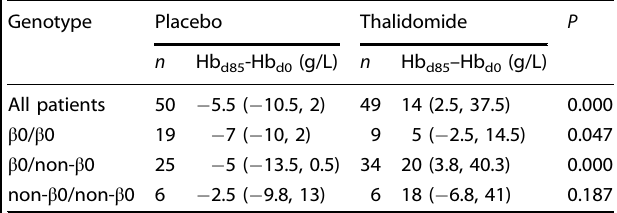
2013.5 (930.3, 4428.4) g/L in 72 weeks (Supplementary Table 12). Quality of life and adverse effects Thalidomide improved the Eastern Cooperative Oncology Group (ECOG) scores, in that after 12 weeks of treatment, patients upon thalidomide had lower ECOG scores (0.8 ± 0.7) than patients upon placebo (1.4 ± 0.5; P < 0.001; Supplementary Table 13), where higher scores indicate greater disability (ECOG score has a scale from 0 to 5; a score of 0 indicates no symptoms, and 1 indicates mild symptoms). Physical health ( P = 0.033), insomnia ( P = 0.033), and dyspnea ( P = 0.054) were improved in patients taking thalidomide as re fl ected by the Transfusion-dependent Quality of Life (TranQoL) questionnaire and the European Organisation for Research and Treatment of Cancer (EORTC) Quality of Life Questionnaire (QLQ) scores (Supplementary Table 13). Some mild adverse events, including drowsiness, dizziness, fatigue, pyrexia, sore throat, rash, abdominal pain, nausea, anorexia, fl ustered, constipation, limbs edema, and headache, were reported in patients of both groups, where grade I – II dizziness ( P = 0.016), drowsiness ( P = 0.057), nausea ( P = 0.051), and rash ( P = 0.071) were more frequently reported in patients